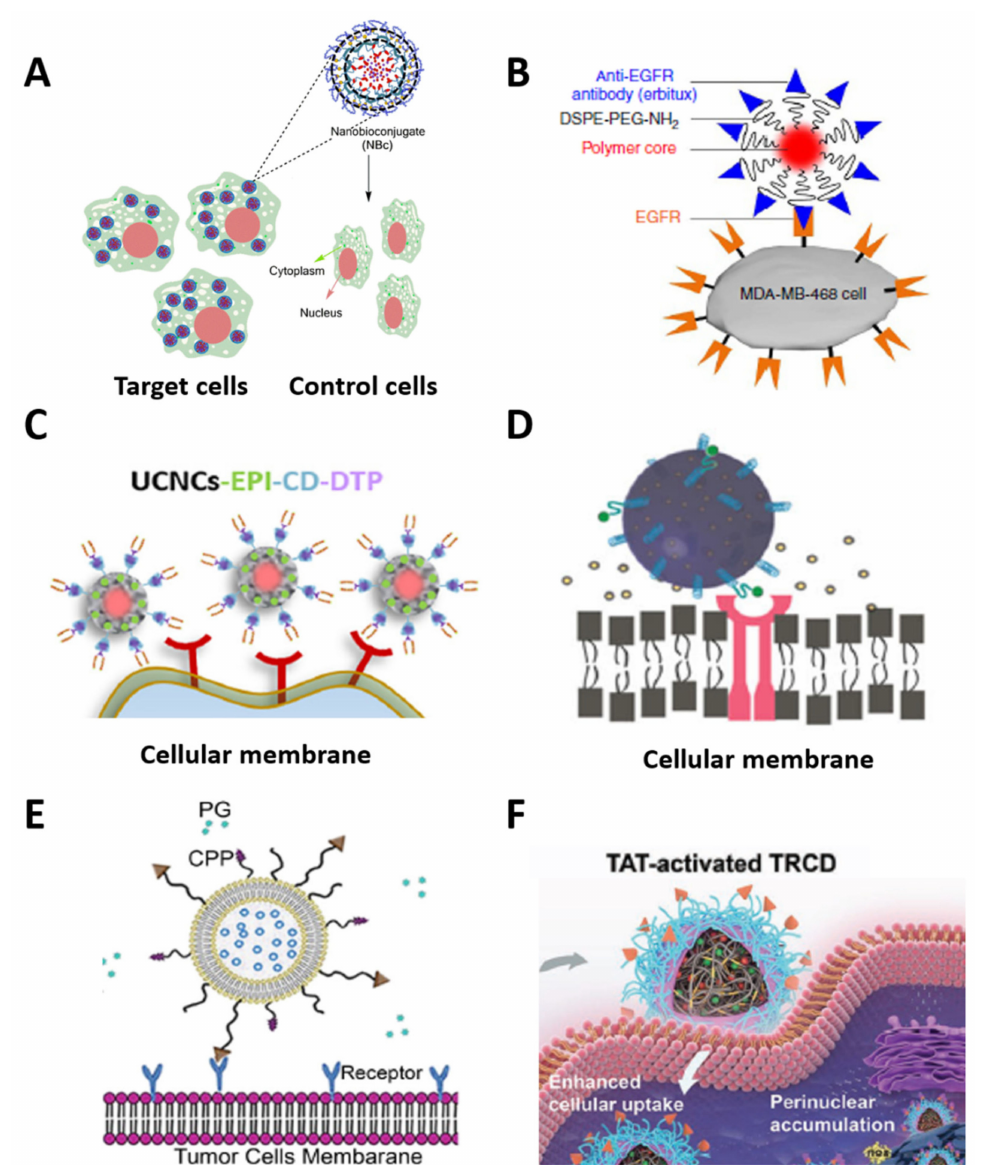
Figure 7. Schematic representation of phototriggered nanocarriers functionalized with cell-targeting biomolecules for specific cargo delivery and imaging: ( A ) cell-specific photosensitive nanobioconjugates for cargo delivery in cardiac